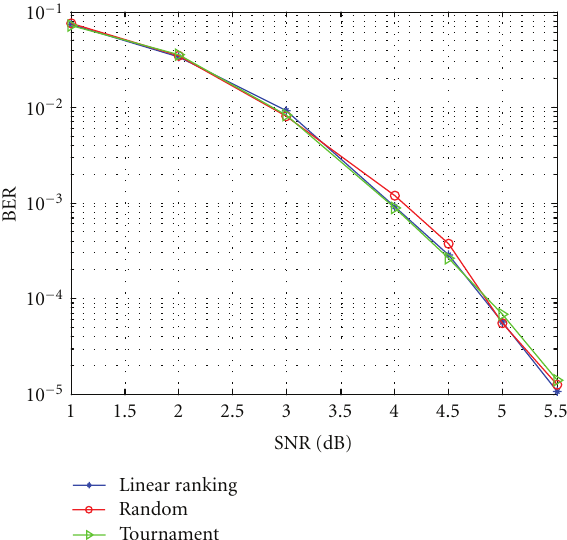
Figure 10: Comparison between di ff erent selection operators in DDGA.